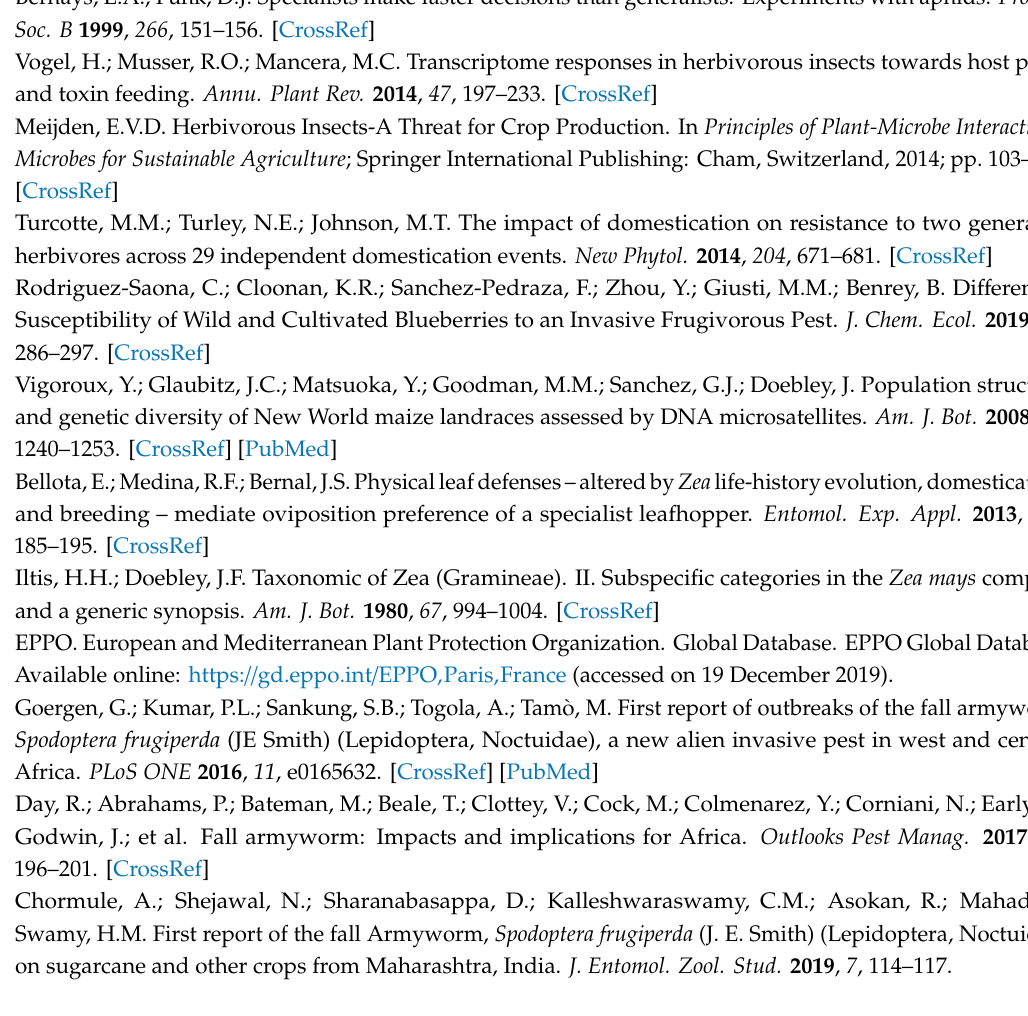
Figure S1: a. Four-way olfactometer set-up for testing olfactory response of L3 larvae of S. frugiperda to cues of potential attractant or repellent plants; b. Flowmeter; c. Central glass choice arena with four arms; d. Vacuum pump; e. Plant with aerial part isolated with aluminum foil; f. Air-tight glass chamber containing negative control (clean air); g. Air-tight glass chamber containing a plant (source of volatile compounds), Table S1: Sigmoidal models adjusted for S. frugiperda larvae weight prediction in di ff erent grasses, Table S2: Mean ( ± SEM) trichome density of the abaxial surface of three sections of 30-day-old grass leaves in Yautepec, Morelos,